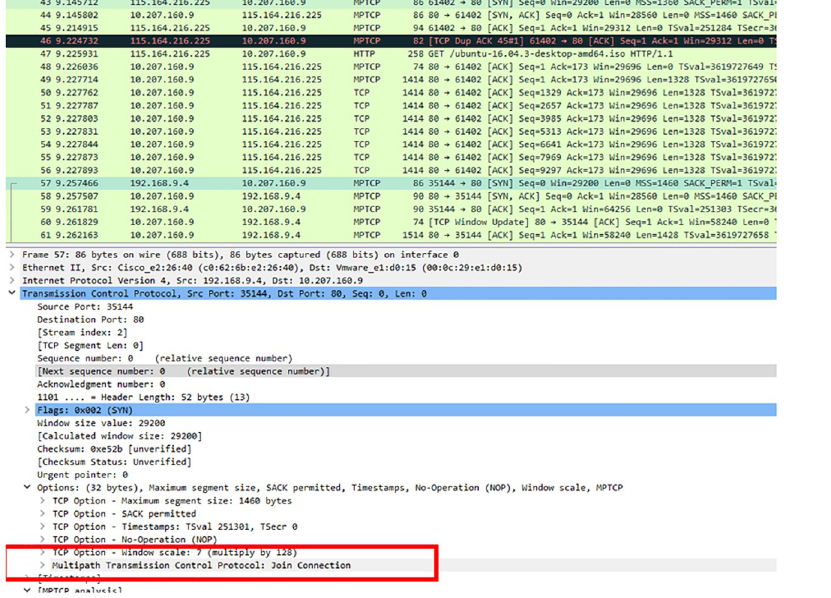
Fig 25. New subflow for data